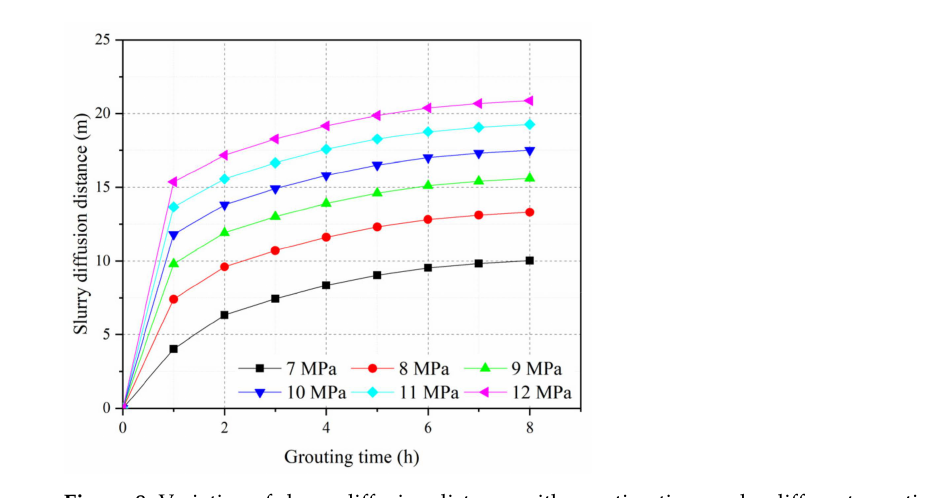
Figure 8. Variation of slurry diffusion distance with grouting time under different grouting pressures.